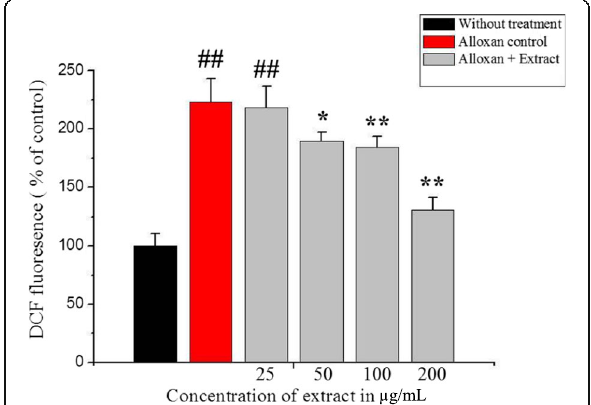
Fig. 5 Protective Effect of C. crepidioides extract on alloxan-induced ROS in INS-1 cells. DCF fluorescence reflects ROS level. Values were represented as mean ± SD from three independent experiments. ## p < 0.01 as compared with the control group; * p < 0.05 and ** p < 0.01 as compared with the alloxan control group. Intracellular ROS activity results for INS-1 cell line induced with 200 μ M of alloxan